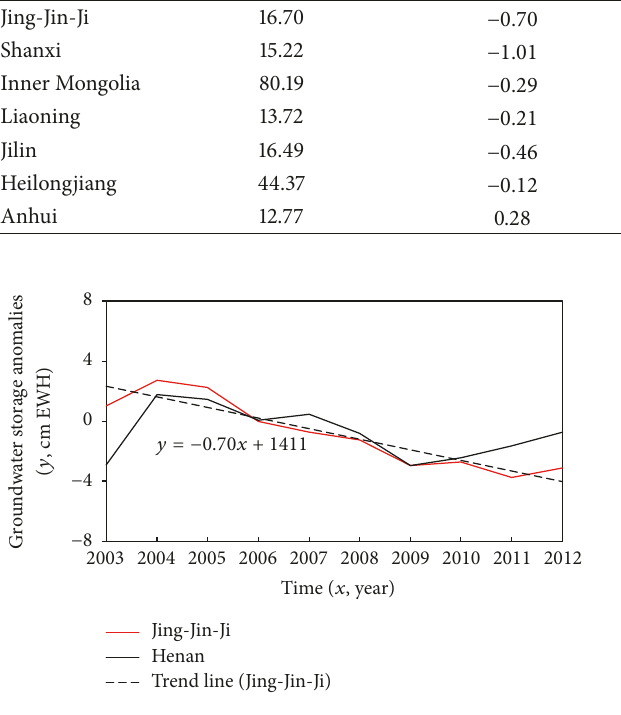
Figure 10: Change rate of groundwater storage in Jing-Jin-Ji region and Henan province involved in the SNWT